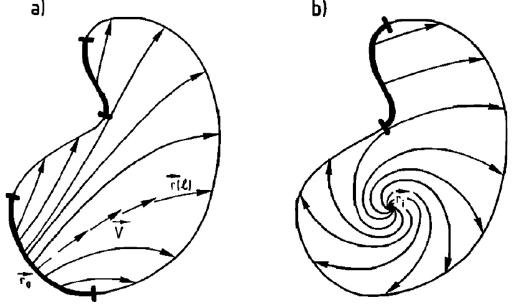
Fig. 6. Sketch illustrating the relation between the tangent field V , the characteristic r (l) generated by V , and the two types of bound- aries of the domain, the “influencing” and “dependent” boundaries. The boundary curve is drawn as a heavy line where it is of the “in- fluencing” type. Note how in (b) the presence of a singular point changes the characteristics and diminishes the “influencing” part on the boundary curve as compared to (a) , the case without a singular- ity. Reproduced from Inhester et al.